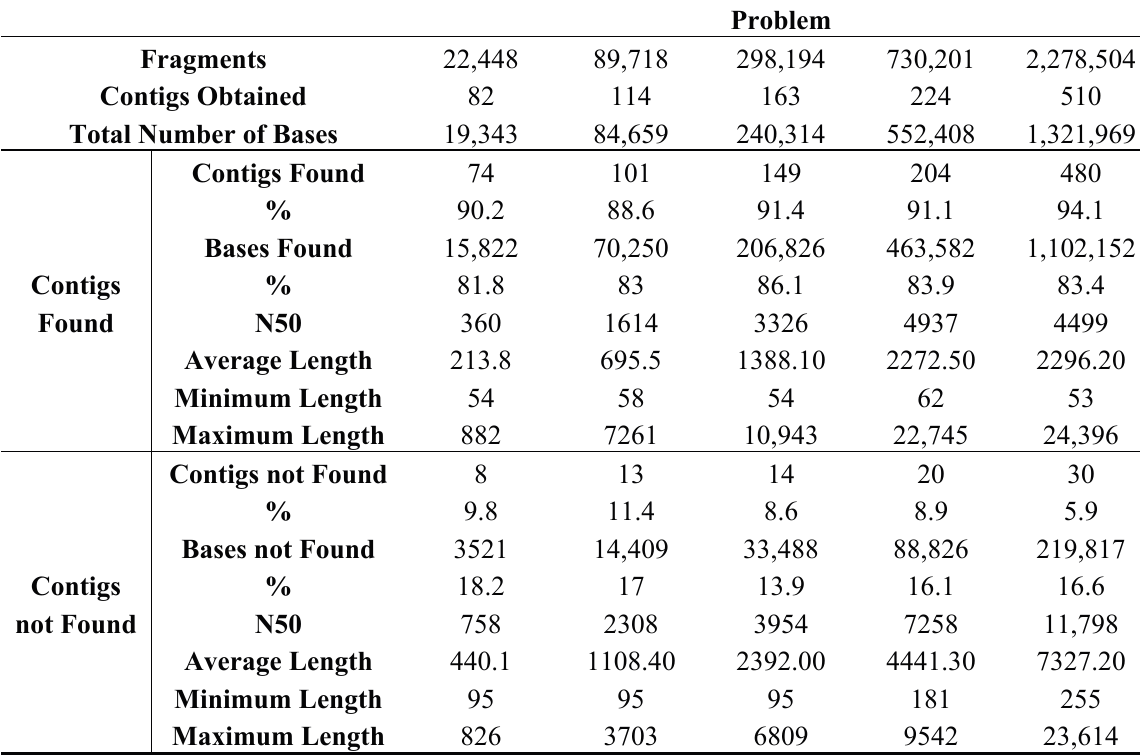
Table 6. Algorithm 1, F 1 objective function, all overlaps.